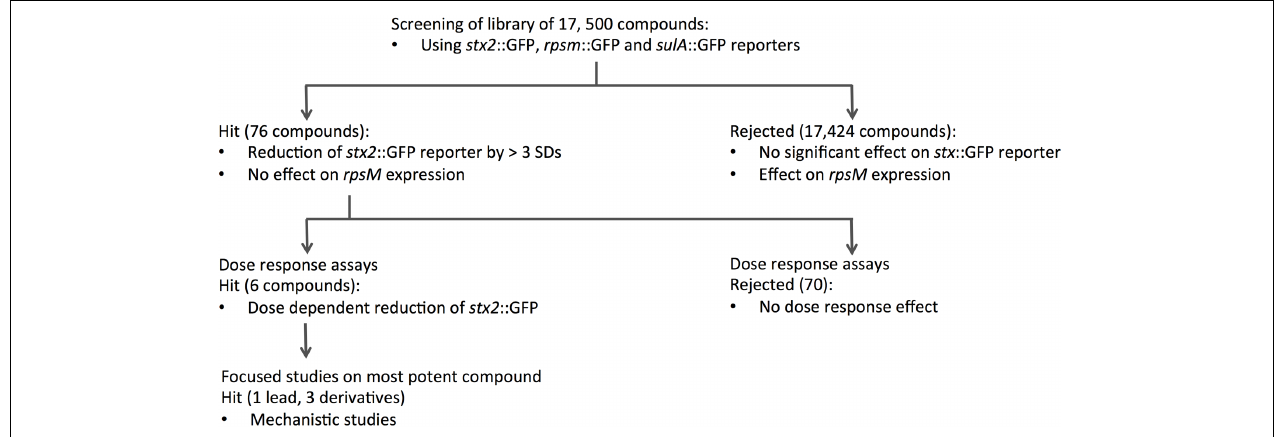
FIGURE 1 | Flow chart summarizing the screening process and DR experiments. A library of 17,500 compounds was screened using stx2:: GFP, rpsm ::GFP and sulA ::GFP reporter fusions. Seventy-six compounds that showed significant activity on stx2:: GFP and suIA ::GFP were identified from this initial screen, and further dose-response assays narrowed this to six hits that reduced stx2 ::GFP expression in a dose-dependent manner. The single most potent compound was taken forward for mechanistic studies.